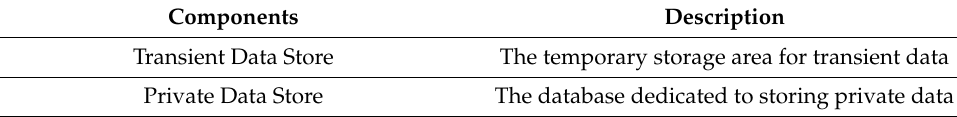
Table 3. More components in the transaction process using private data.